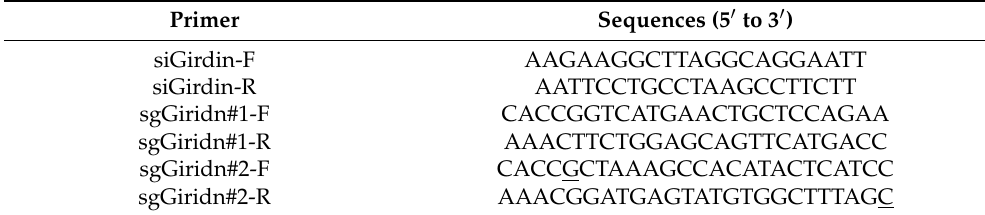
Table 4. The sequence of primers for siRNA and